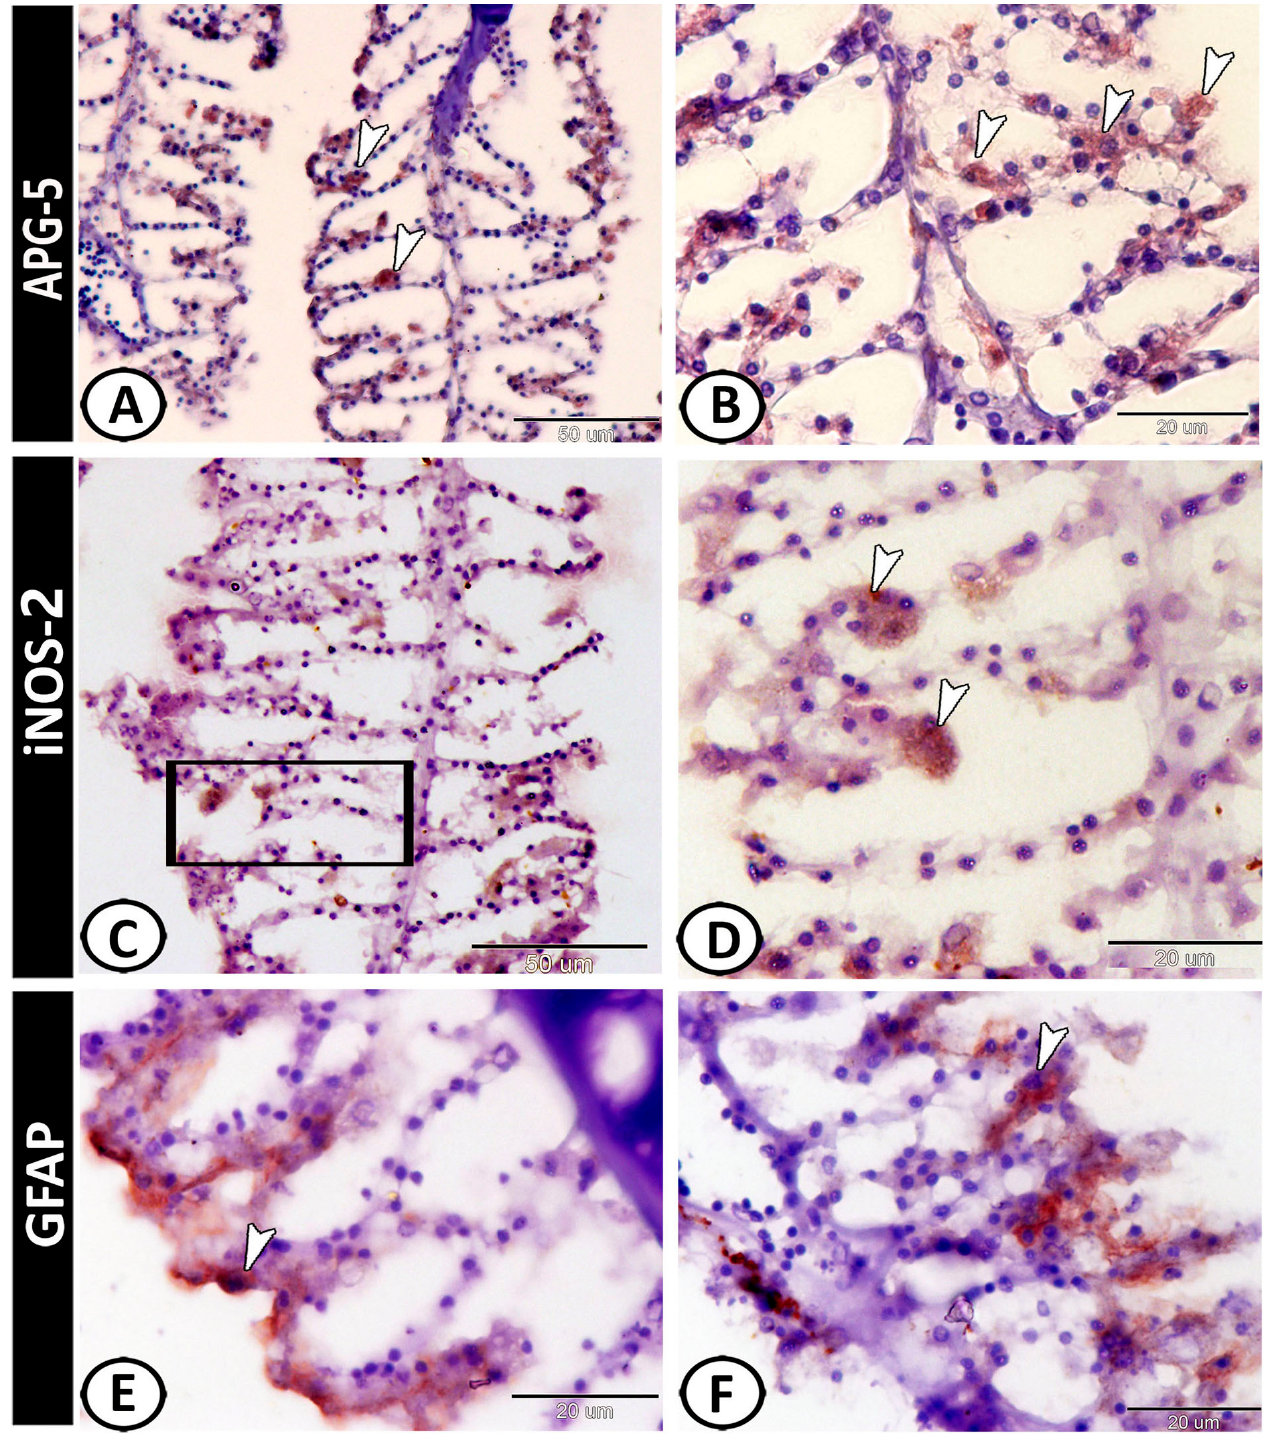
Figure 4. Immunohistochemistry of APG-5, iNOS-2, and GFAP. ( A , B ) The immunohistochemical analysis revealed APG-5 positive immunoreactivity of macrophages (arrowheads). ( C , D ) iNOS-2 was expressed in macrophages (arrowheads). ( E , F ) The epithelium of the primary and secondary gill lamellae contained positive-GFAP astrocytes (arrowheads). Both IL-1 β and NF- κ B showed immunoreactivity in the inflammatory cells (including monocytes and macrophages) of the gill filaments (Figure 5A–D), Furthermore, macrophages expressed TGF-B (Figure 5